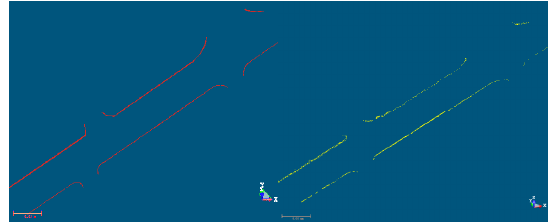
Figure 14. The road curb of Auriga Dr. Left: truth data. Right: the extracted curb.